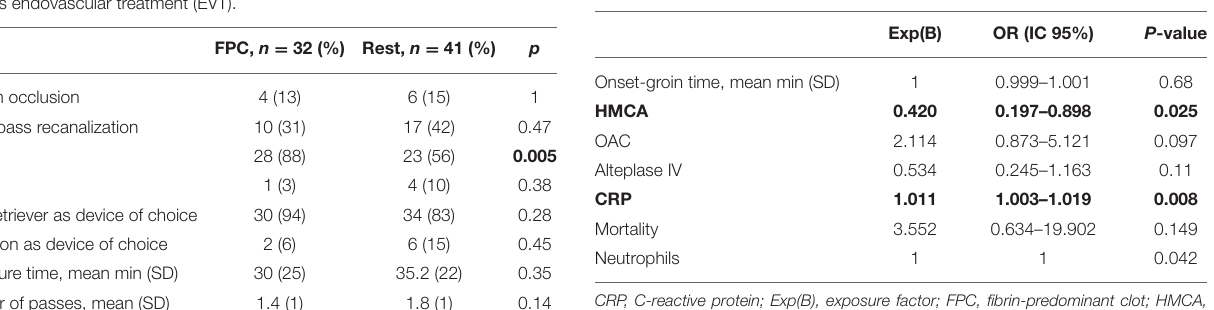
TABLE 4 | Multivariate analysis: predictors of the fibrin-predominant clot (FPC) in all cohorts.